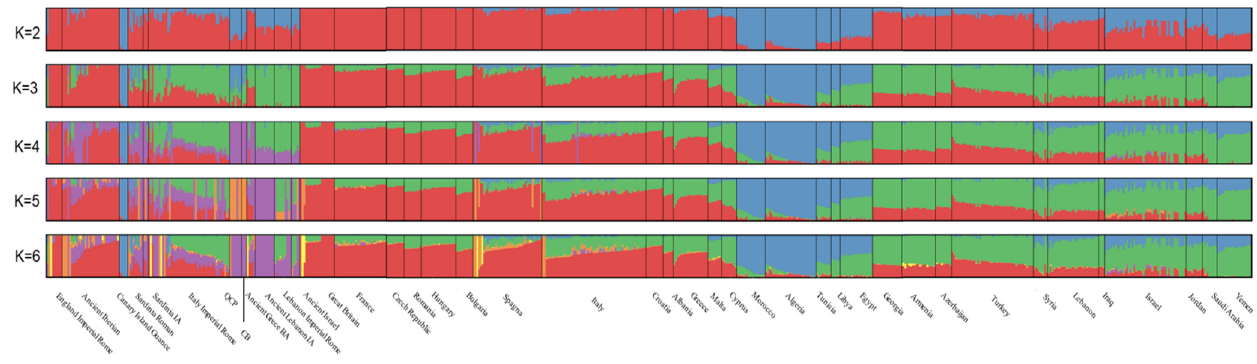
Figure 3. ADMIXTURE results from K = 2 to K = 6.